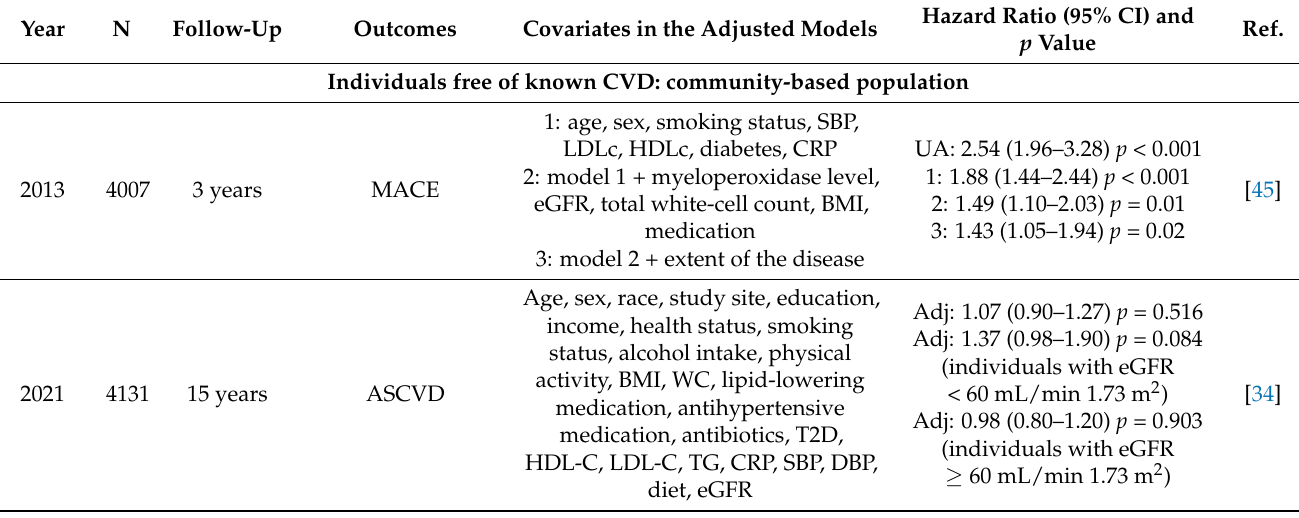
Table 1. Prospective studies about TMAO and adverse